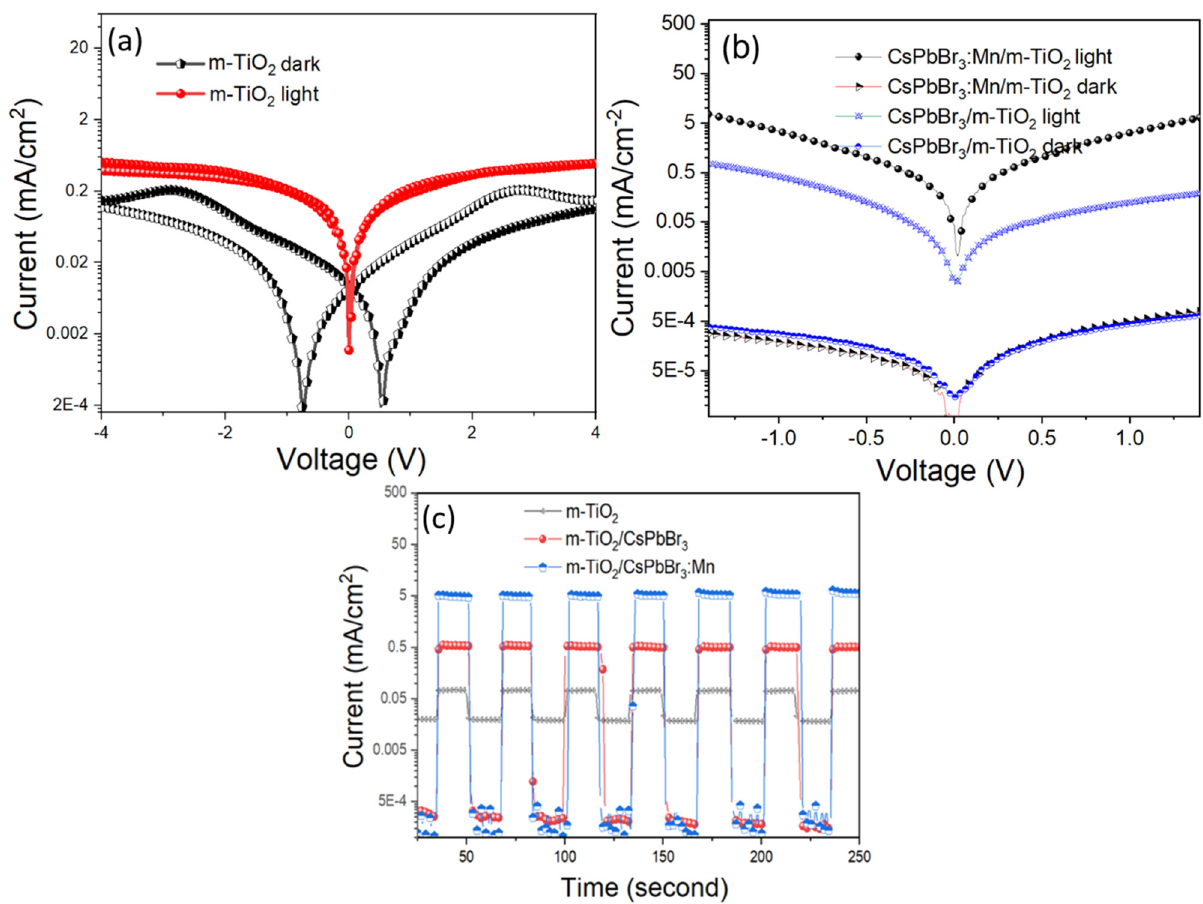
Figure 6: Logarithmic I – V curves of planar structure photodetector based on ( a ) m - TiO 2 , ( b ) m - TiO 2 /CsPbBr 3 and m - TiO 2 /CsPb 1 – x Mn x Br 3 – 2 x Cl 2 x ( x = 0 – 0.5 ) composite fi lms in the dark and NUV light irradiation. ( c ) Photocurrent – time response measured in the dark and under illumination under 1.5 V